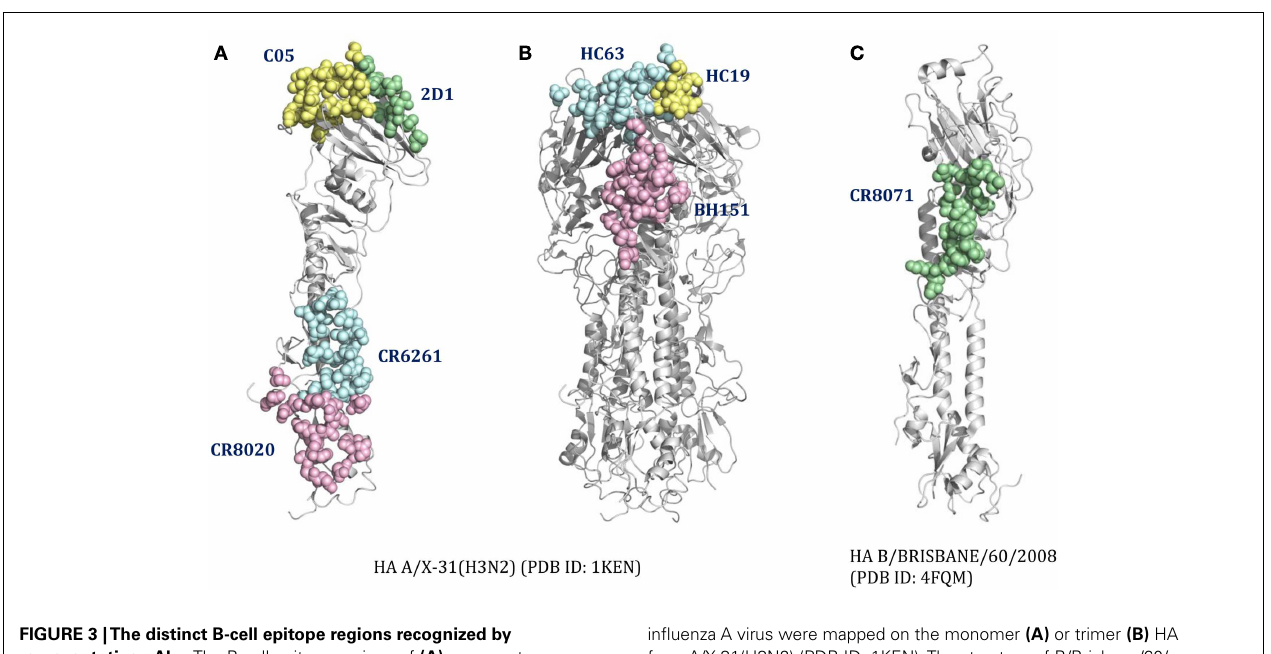
influenza A virus were mapped on the monomer (A) or trimer (B) HA from A/X-31(H3N2) (PDB ID: 1KEN).The structure of B/Brisbane/60/ 2008 HA (PDB ID: 4FQM) was used as a template structure for influenza B virus. Different colors here were used for distinguishing B-cell epitope